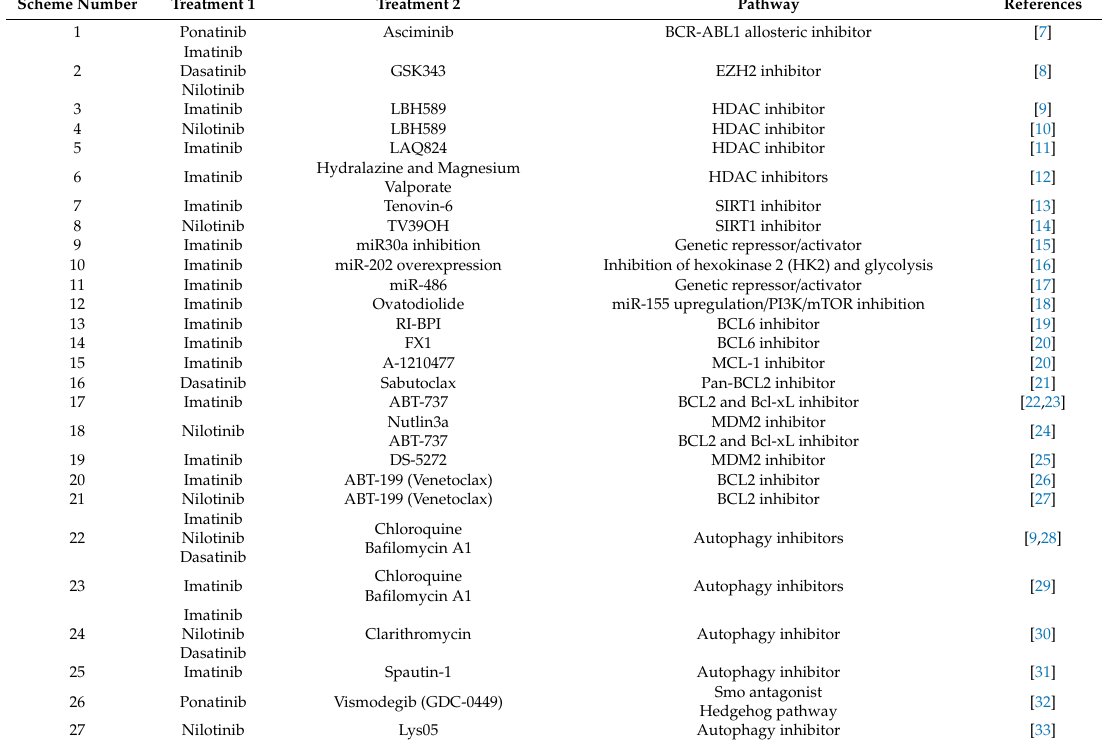
Table 1. Chronic Myeloid Leukemia (CML) Treatments with Ex-Vivo Evidences of E ff ectiveness either in Combination with tyrosine kinase inhibitor (TKIs) or